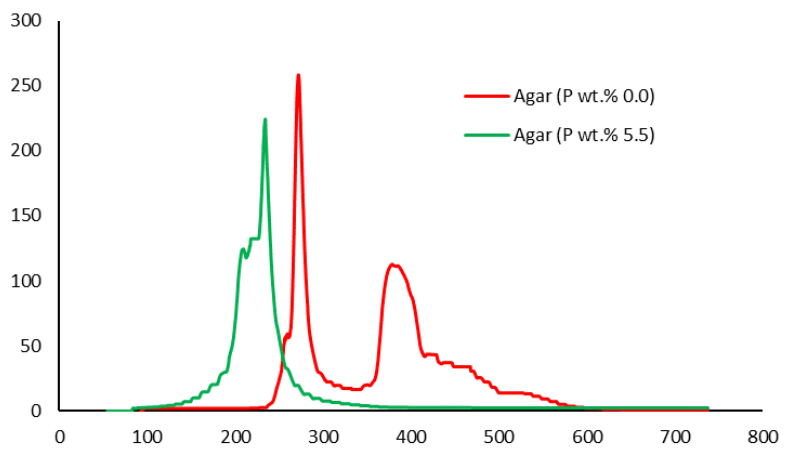
Figure 11. Plot of heat release rate (HRR) (W/g) versus temperature (°C) for modified and unmodified versions of agar.